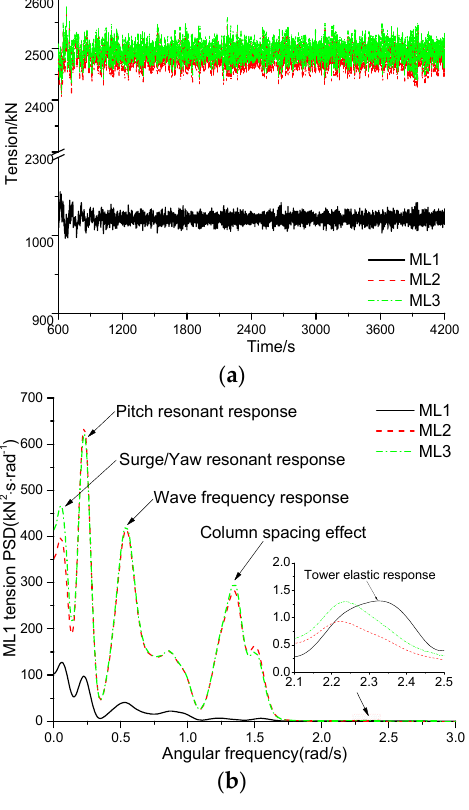
Figure 12. Time histories and power spectra of mooring line tension response in the rated wind speed (LC3) case. ( a ) Time histories of mooring line tension; ( b ) power spectra of mooring line tension.